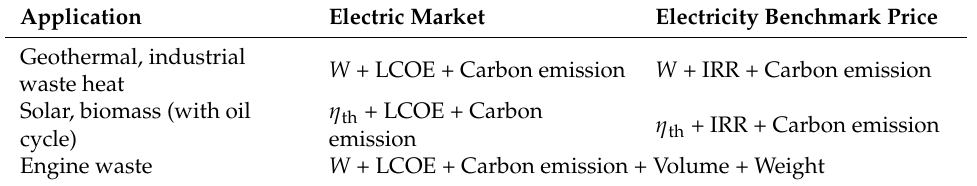
Table 8. Recommended optimization objectives for different ORC